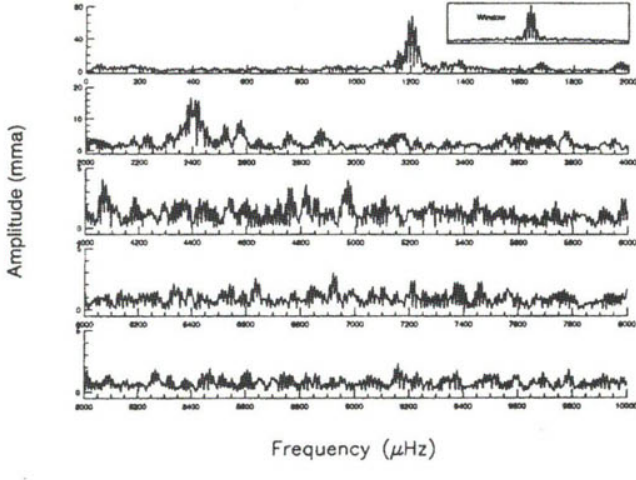
Fig. 12. The FT for the November 1990 data on G 191-16.